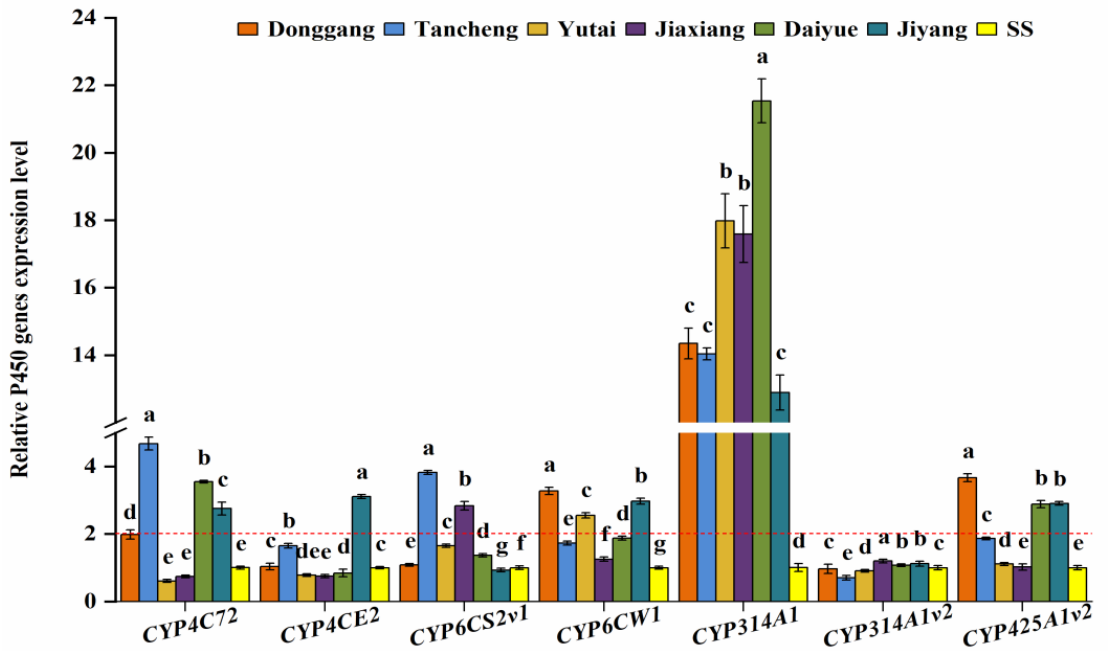
Figure 2. The relative expression levels of seven P450 genes in six L. striatellus populations from Shandong Province compared with SS (red dotted line means 2-fold overexpression level). The data are the mean ± SE ( n = 3), and different letters on the bars indicate significant differences ( p < 0.05).